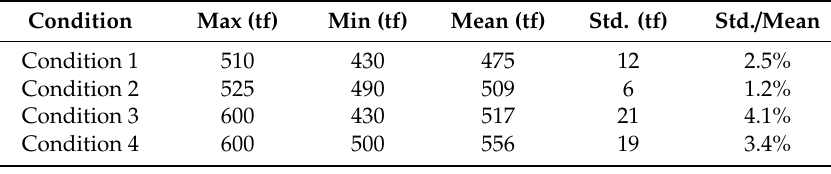
Table 4. Statistics of interacting forces.